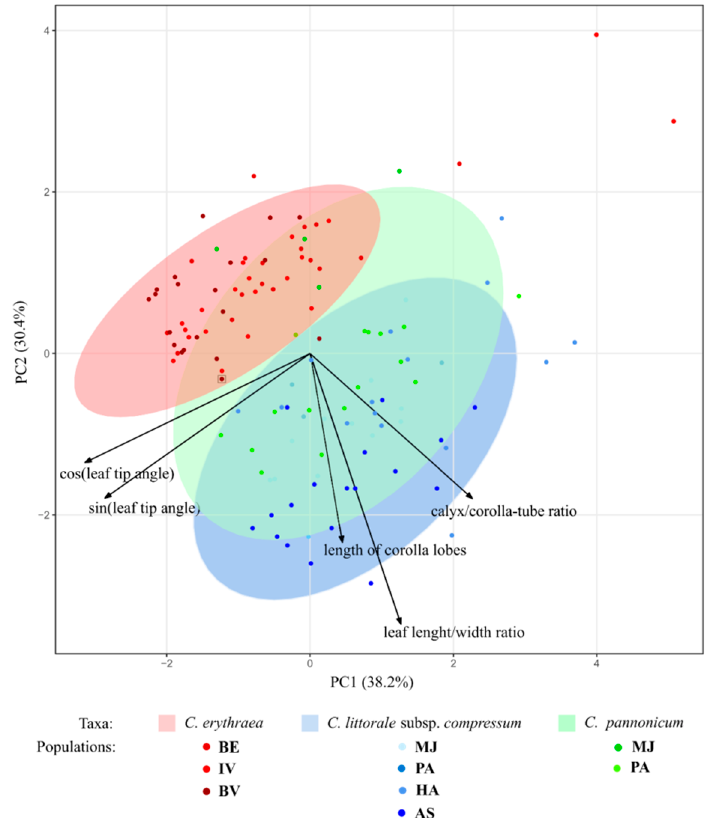
Figure 1. PCA biplot of three Centaurium taxa ( C. erythraea , C. littorale subsp. compressum and C. pannonicum ) based on the following characters: length / width ratio of floral stalk leaves, calyx / corolla-tube ratio, length of corolla lobes, and leaf tip angle, which was decomposed to the sine and cosine components. The scatterplot consists of 127 individuals in the plane of the first and the second principal coordinates. Feature loadings were scaled by multiplying with 5 so they could be more readily observed on the graph.